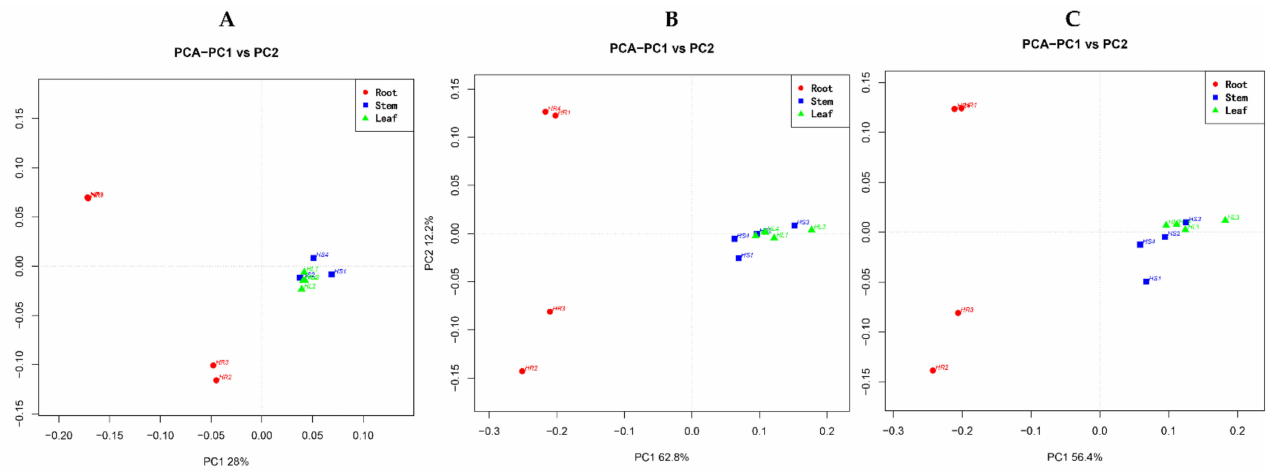
Figure 4. The principal component analysis (PCA) of the community of endophytic fungi within different plant organs including the roots, stems, and leaves. ( A ) PCA was conducted at OUT level, ( B ) PCA was conducted at the genus level, ( C ) PCA was conducted at the family